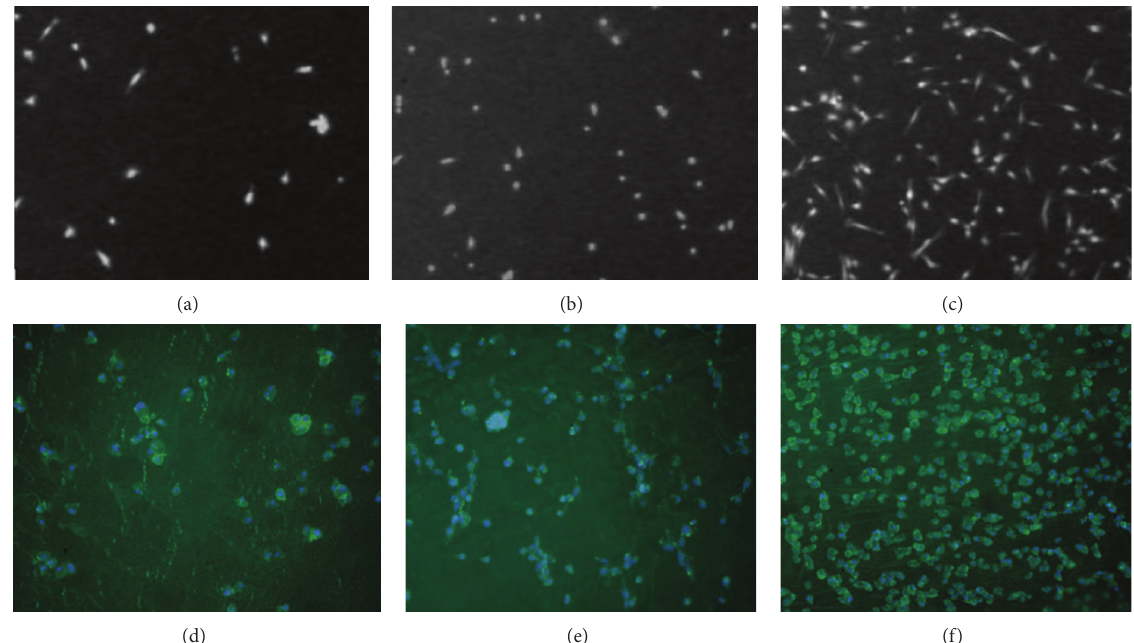
Figure 4: Fibroblast cellular proliferation of uncross PVA/GE and cross-linked IPN PVA/GE blend after 1 ((a), (d)), 3 ((b), (e)), and 5 ((c), (f)) days using the optical microscope